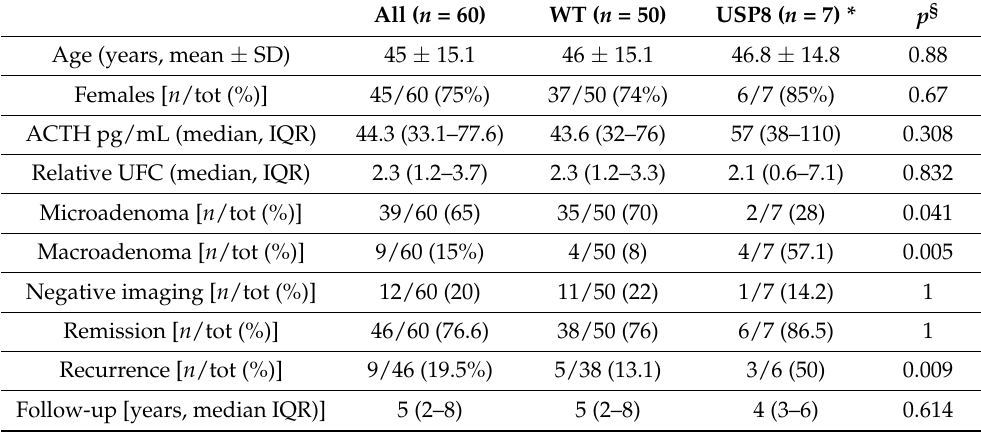
Table 1. Demographic, clinical, and neuroradiological characteristics of CD